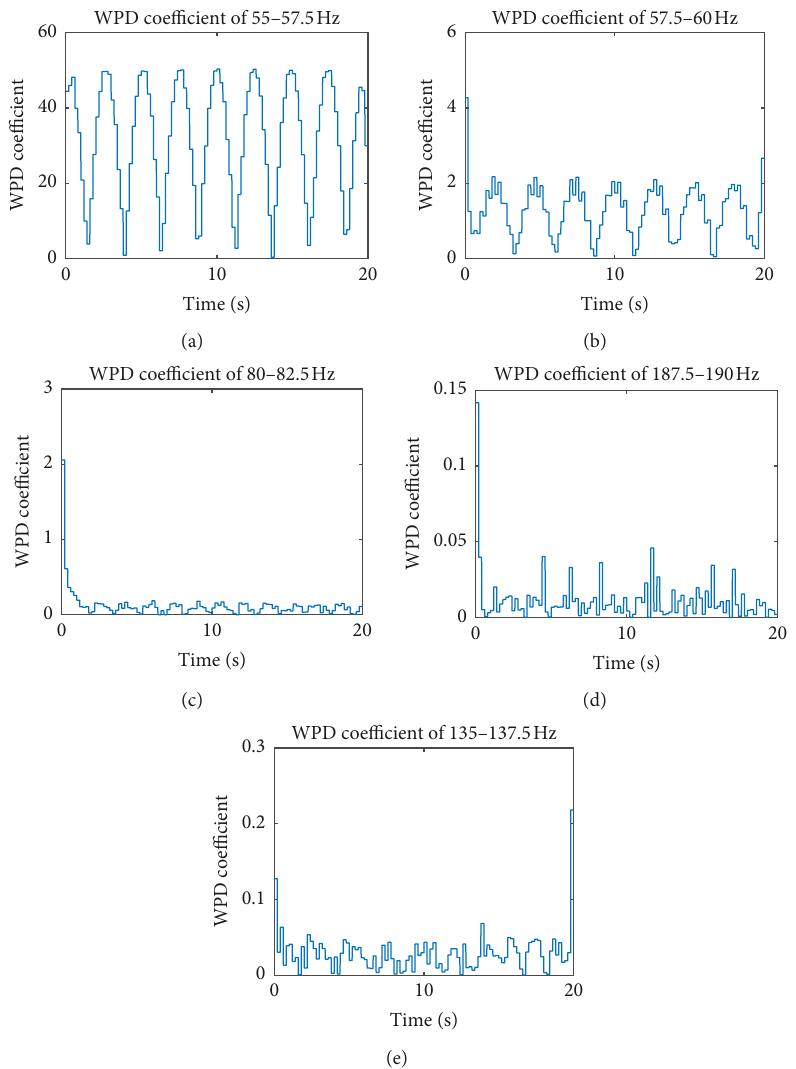
Figure 16: Wavelet coefficients related to (a) f s , (b) F BRB , (c) F MIS , (d) F ORF , and (e) F IRF under the broken rotor bar